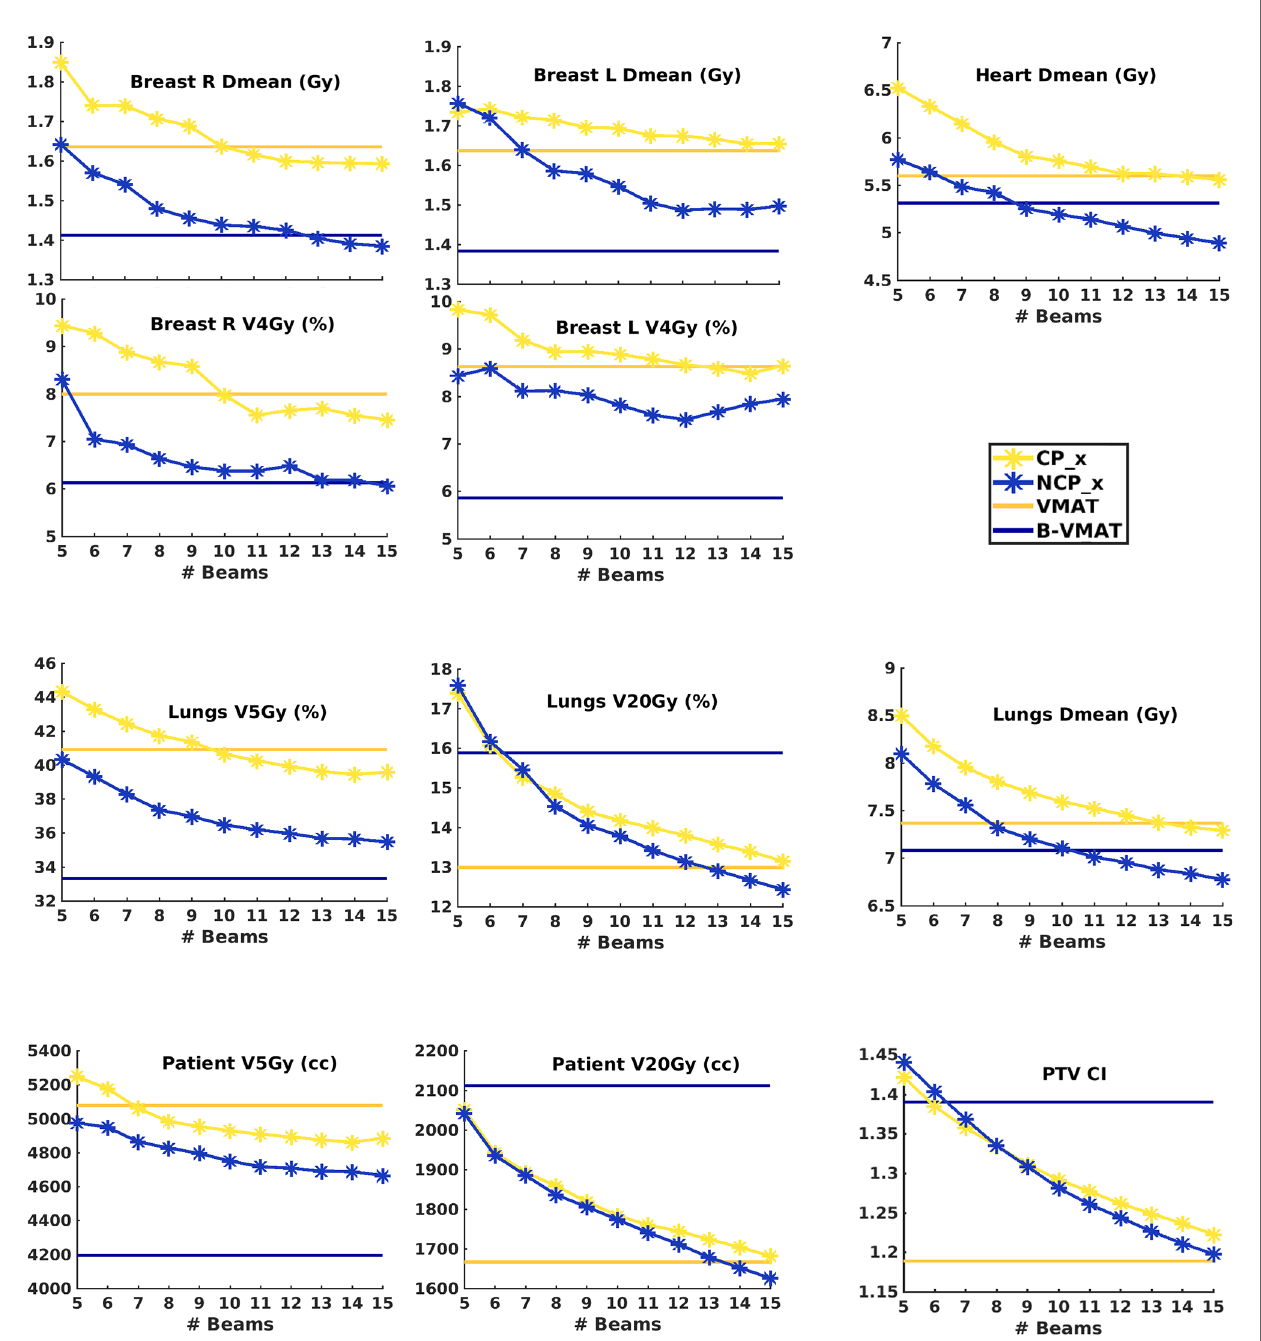
FIGURE 2 | Population mean dosimetric plan parametersfor CP_xand NCP_xas a function of the number of beams per plan (x).The dashed horizontal lines indicate the population mean values for VMAT and B-VMAT. p-Values for beam con fi guration comparisonsare presented in Figure B2 inElectronic Supplement B